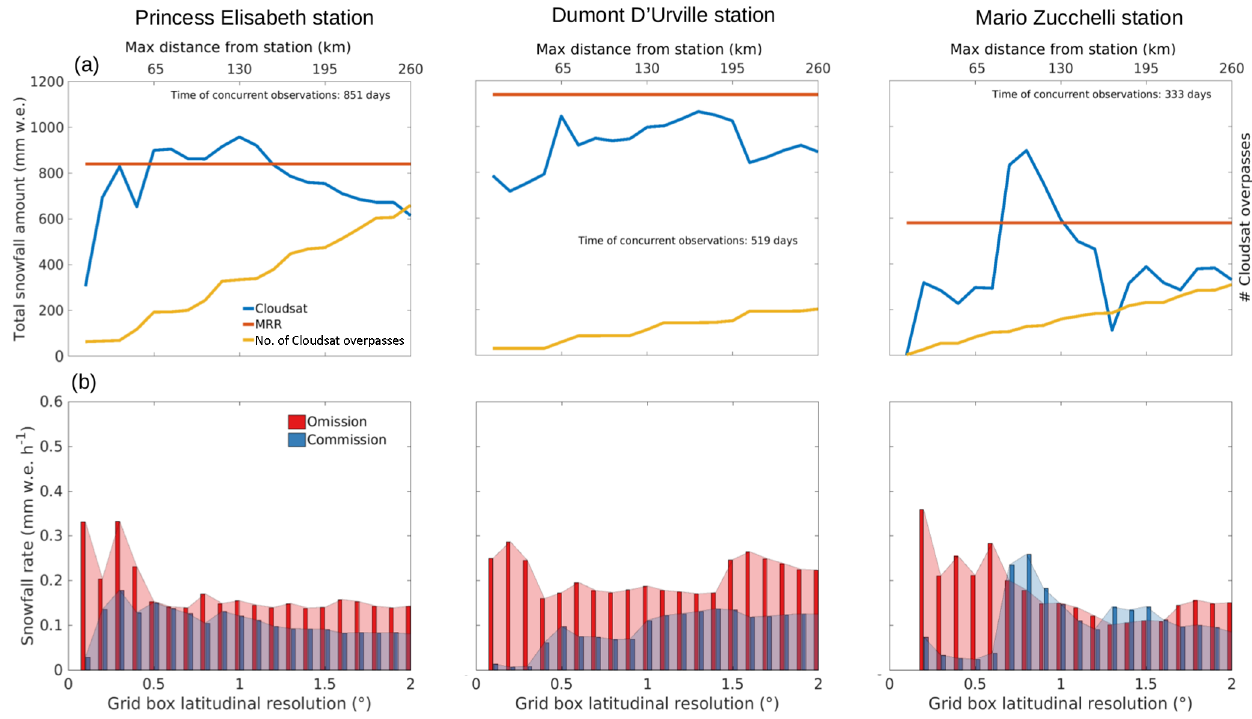
Figure 6. (a) Overview of the total snowfall amounts for the three stations as observed by CloudSat and the Micro Rain Radars during the periods of collocated measurements (Fig. 2). (b) Individual snowfall event error analysis. As Micro Rain Radar snowfall rates are considered truth, omission errors are defined as an underestimation, while commission errors are an overestimation of snowfall rates by CloudSat. The x axis denotes different spatial resolutions of the CloudSat climatology (grid box longitudinal resolution = 2 · grid box latitudinal